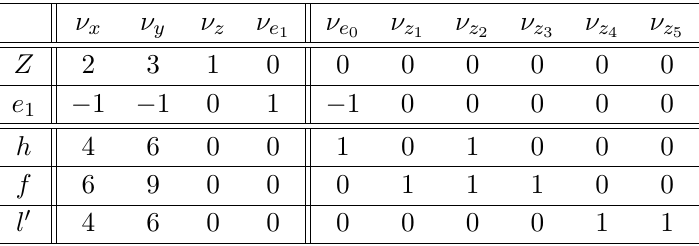
B = F × P 1 , which is related to the base dP 3 1 l 0 simple blowdown.